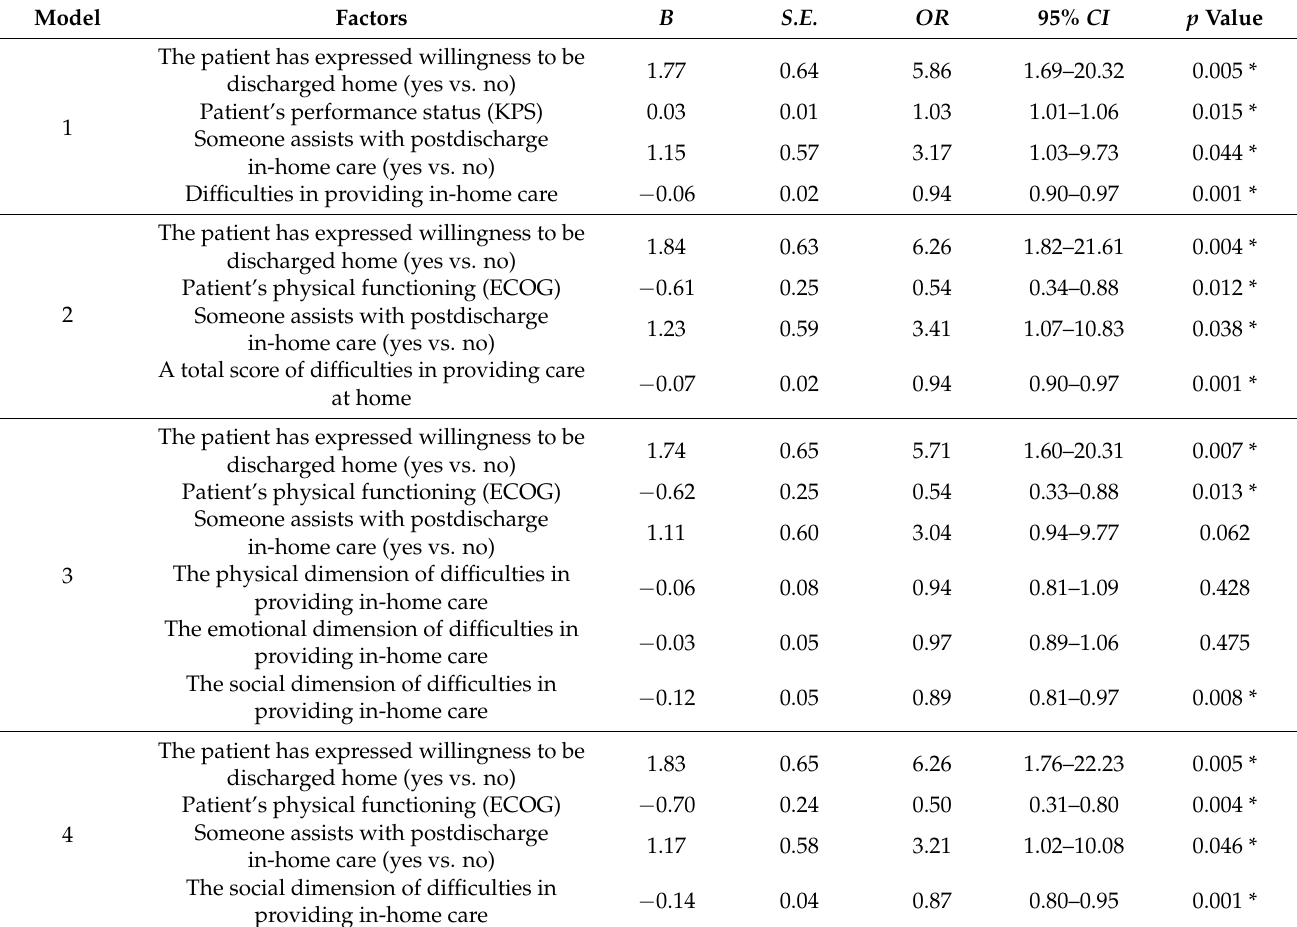
Table 3. Factors predicting family caregivers’ readiness for